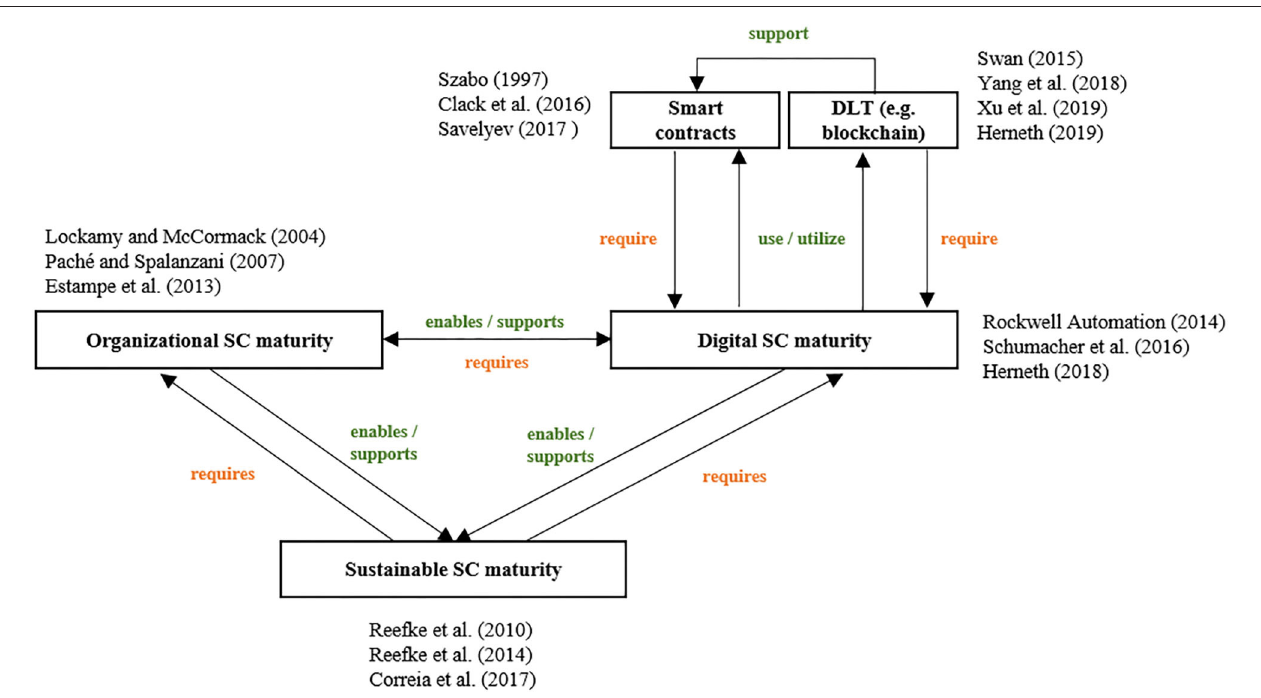
FIGURE 3 | A conceptual framework linking organizational, sustainable, and digital supply chain maturity considering smart contract and blockchain